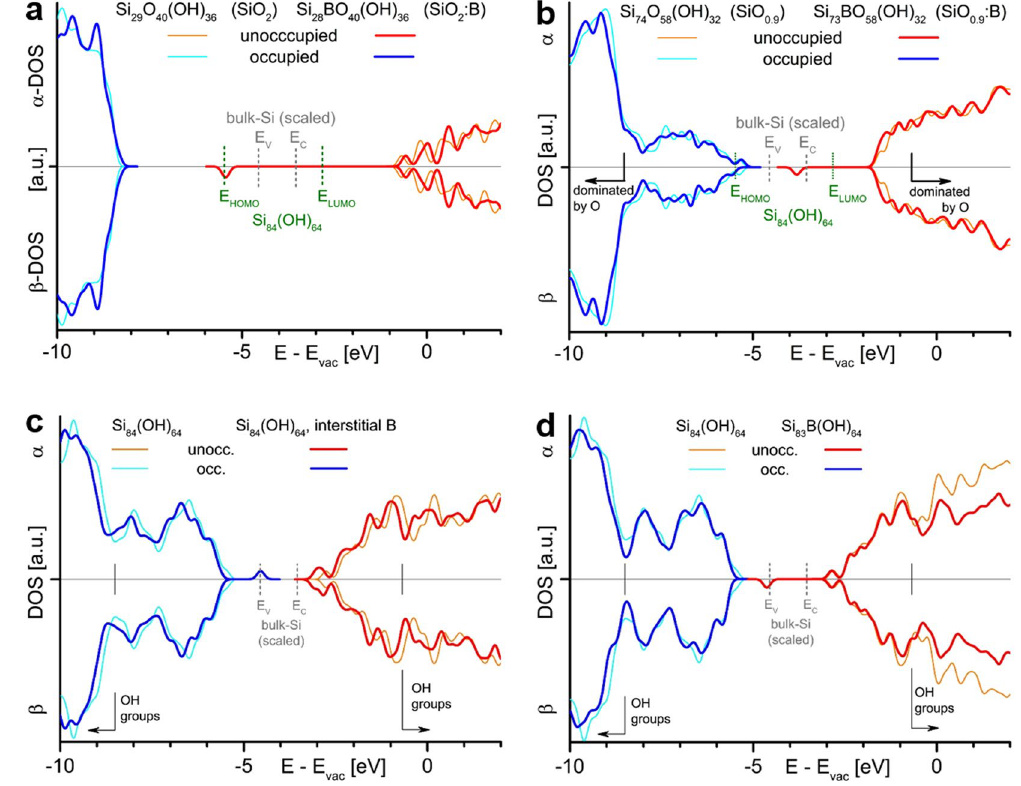
Figure 6. Results of density functional theory (DFT) calculations for B in the Si/SiO 2 system. Density of states (DOS) of pure, intrinsic approximants (unoccupied states in orange and occupied states in cyan) and B-incorporating approximants (red and blue, respectively). ( a ) B in SiO 2 creates an unoccupied state that is only in the energetic vicinity of the highest occupied states (HOS; valence band edge in bulk) for Si NCs ≤ 1.5 nm as indicated by the green dashed line 59–61 but outside of the gap for larger NCs. ( b ) In the suboxide transition shell around the NCs (simulated here as SiO 0.9 ) B introduces an unoccupied state that has almost mid-gap character, which makes it an efficient non-radiative recombination centre. ( c ) For a B-atom on an interstitial site in a Si 84 (OH) 64 approximant (1.5 nm NC) an occupied state close the HOS (VBE in bulk) occurs, whereas for a substitutional B-atom in this approximant ( d ) an unoccupied state at the same energetic position occurs, as expected from conventional B-impurity